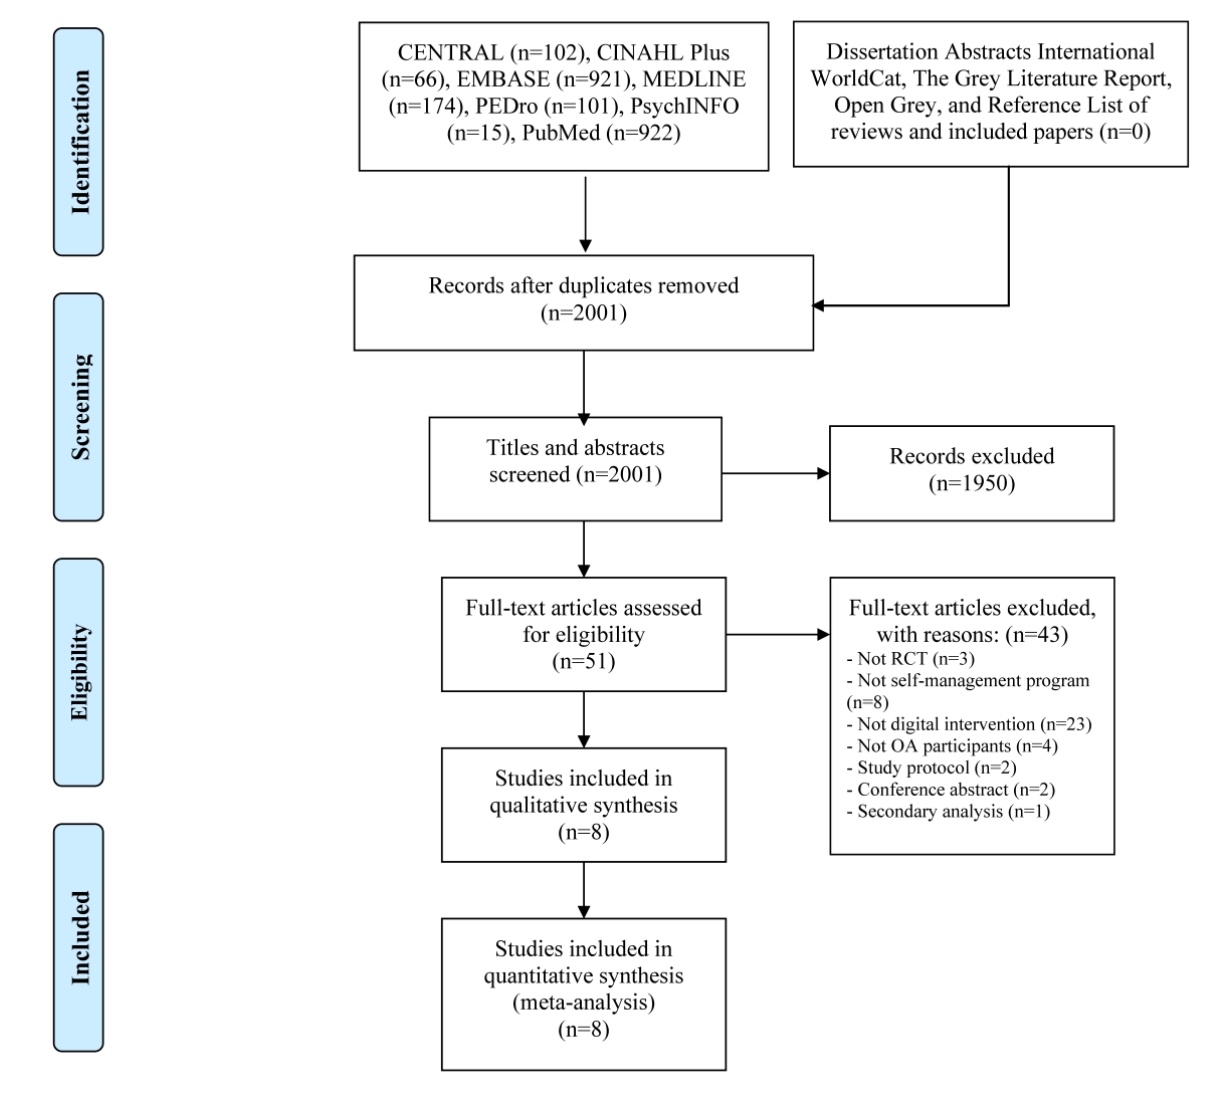
Figure 1. Preferred Reporting Items for Systematic reviews and Meta-Analyses flow diagram. CENTRAL: Cochrane Central Register of Controlled Trials; CINAHL Plus: Cumulative Index to Nursing and Allied Health Literature Plus; EMBASE: Excerpta Medica Database; MEDLINE: Medical Literature Analysis and Retrieval System Online; PEDro Physiotherapy Evidence Database; OA: osteoarthritis; RCT: randomized controlled